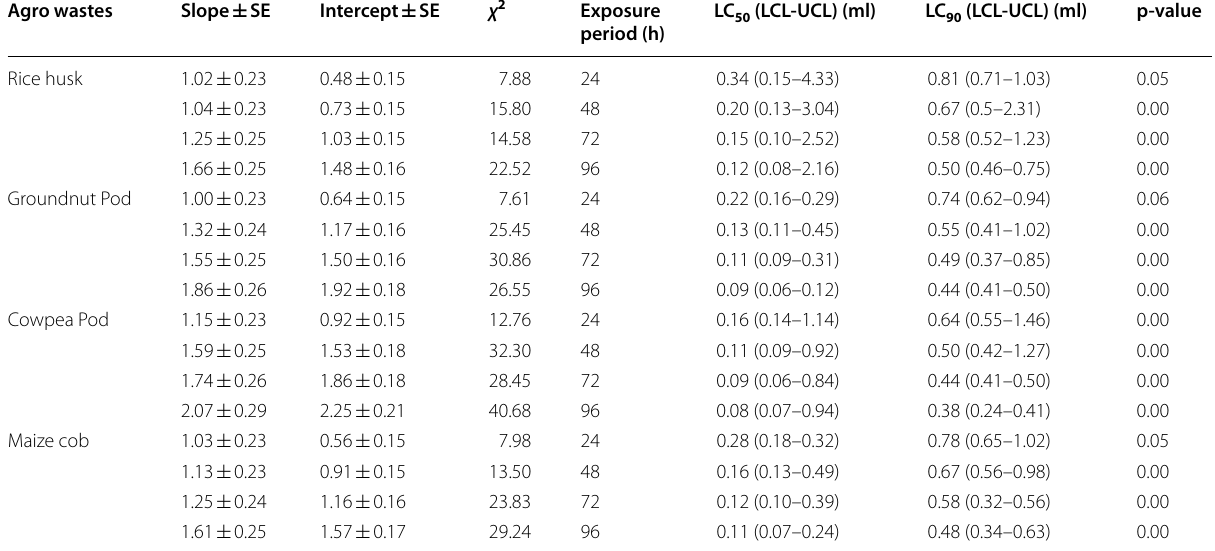
χ 2 Chi-square value, S.E =